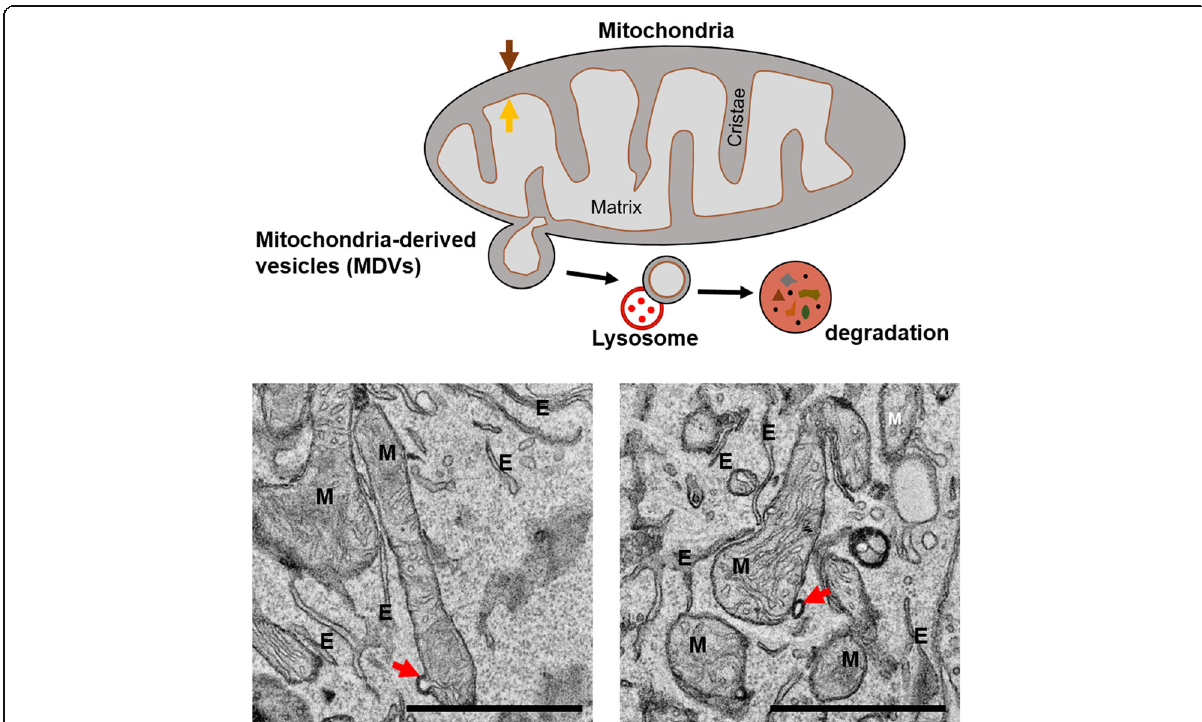
Fig. 3 Schematic model and electron microscopic image of mitochondrial-derived vesicles (MDVs). MDVs are generated from the outer mitochondria membrane and include outer, inner membrane, and matrix compartments (Red arrow). Brown arrow: outer membrane, Orange arrow: inner membrane, M: mitochondria, E: Endoplasmic reticulum, Scale bar: 1 μ